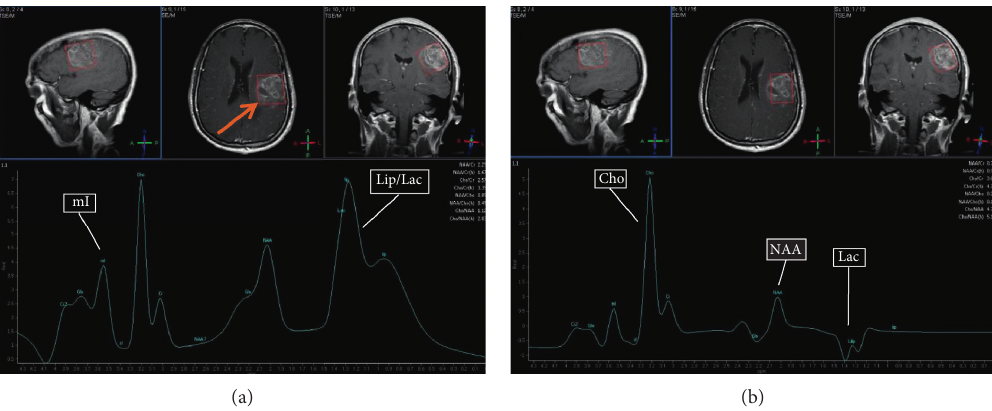
Figure 7: (a) TE 31 msec. (b) TE 144 msec. MRS was performed to differentiate between high-grade and low-grade glioma. The lesion was diagnosed as a high-grade glioma. NAA is reduced. Lipid and lactate are elevated. Choline is markedly elevated. Cho :Cr is 4.74, and Cho: NAA is 5.19. However, at TE31, myo-inositol is slightly increased. Myo-inositol increase has been associated with low-grade gliomas